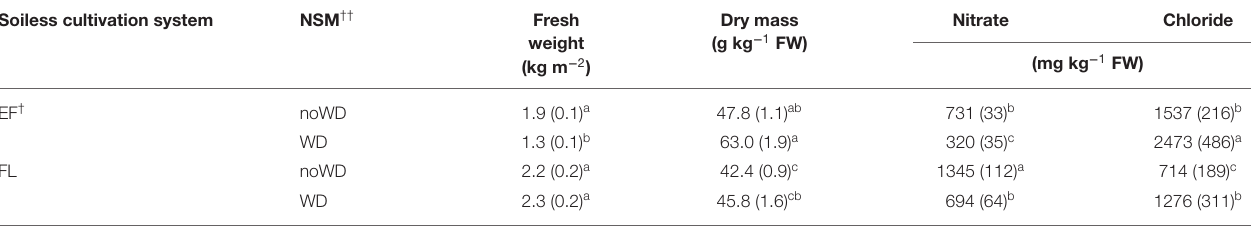
TABLE 6 | Effect of soilless cultivation system and nutrient solution management before harvest on growth, productivity, and nitrate and chloride concentration of romaine lettuce (autumn cycle) leaves, with the standard error of the mean in brackets. Soiless cultivation system